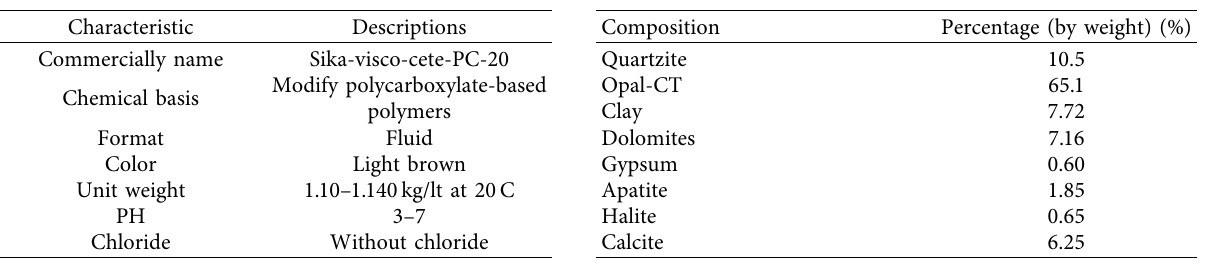
Table 3: Mineral analysis of lightweight (porcelinite) aggregate. ∗ Table 1: Characteristics of the superplasticizer.